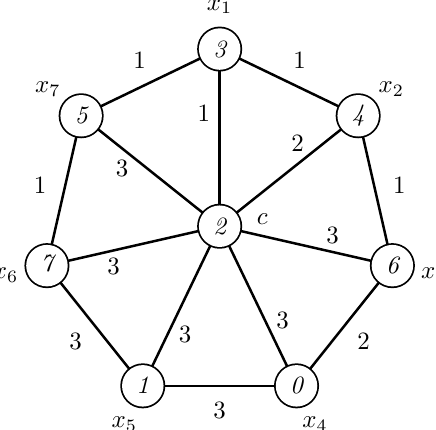
Figure 5. A modular irregular 3-labeling of W 7